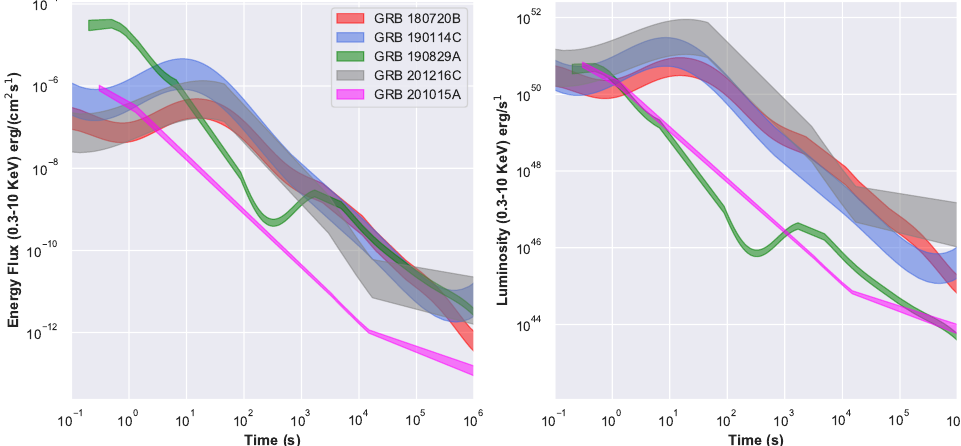
Figure 2. X-ray light curve of the four VHE GRBs shown as flux ( left ) and luminosity ( right ) using data from the Swift-BAT and XRT. Curves represent a smooth interpretation of the light curve evolution (using Gaussian processes); the width of the line gives an indication of the spread of data points. GRB160821B is not shown in this plot because, as a short GRB, it is not directly comparable.